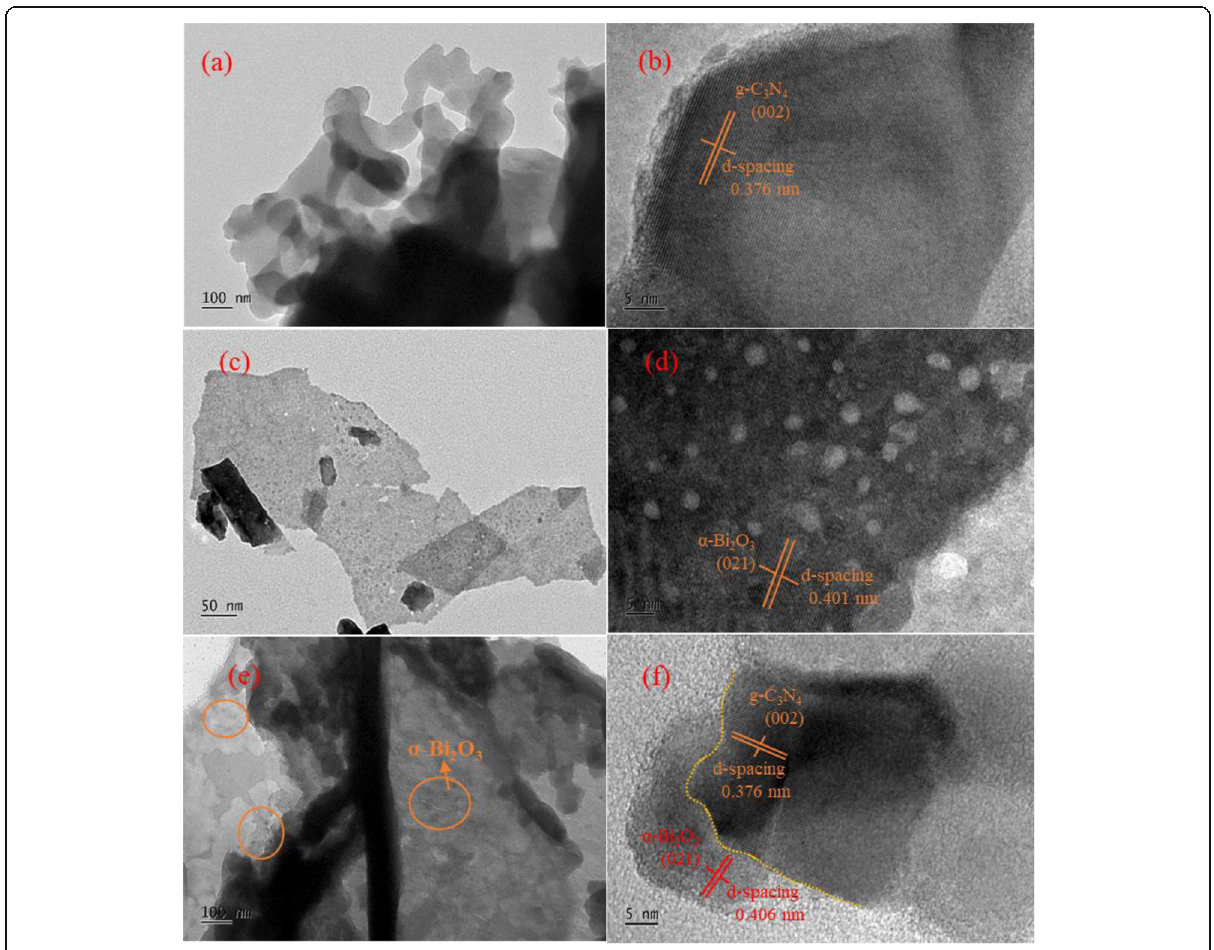
Fig. 3 TEM and HRTEM images of ( a and b ) g-C 3 N 4 , ( c and d ) α -Bi 2 O 3 and ( e and f ) 1 wt% α -Bi 2 O 3 @g-C 3 N